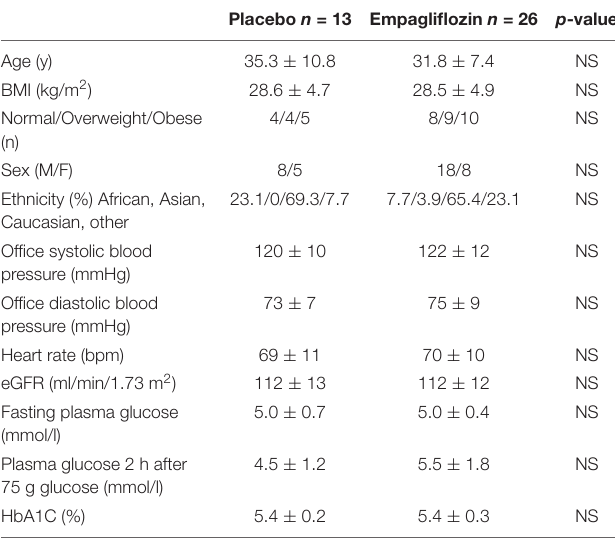
TABLE 1 | Clinical characteristics of enrolled subjects by randomization having completed all ABPM